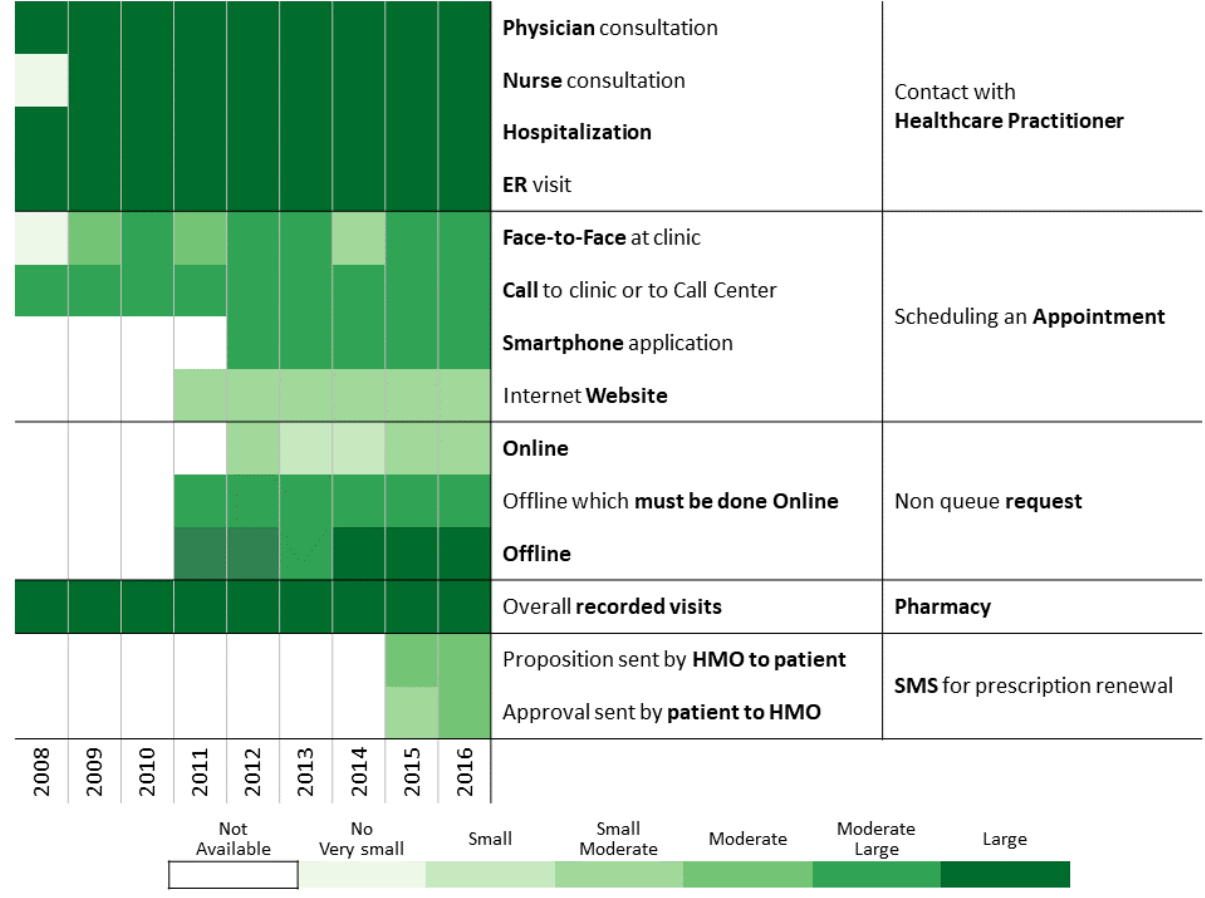
Figure 18. Communication pattern changes between 2008 and 2016 for patients with diabetes having an overall high number of contacts with health care